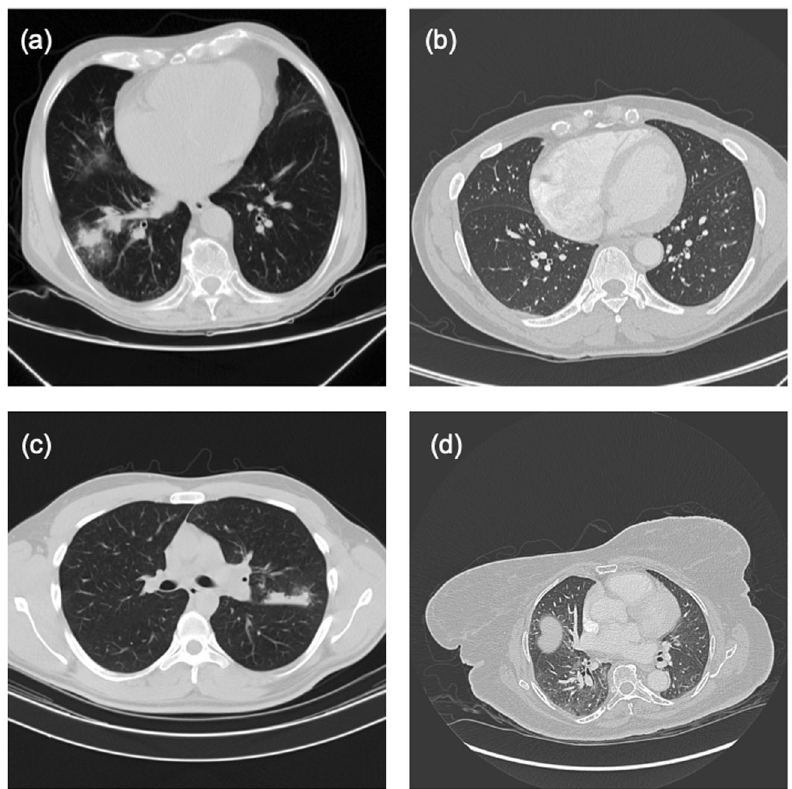
Fig. 6 Representative examples of CT images used to test the performance of CovidCTNet versus radiologists. a A CT image of CAP. This image is misidenti fi ed as Covid-19 or control by two out of four radiologists and correctly diagnosed by CovidCTNet. b A CT image of control, that was misdiagnosed by three out of four radiologists as Covid-19 or CAP and correctly diagnosed by CovidCTNet as control. c A sample of Covid-19 that was detected as Control by CovidCTNet and as Control or CAP by three out of the entire panel of radiologists (four members). d Image of control that was misdiagnosed by the CovidCTNet as CAP and by two radiologists as Covid-19 or control. Note that, in this fi gure one single slide of the entire scan is shown as a representative of all CT images of a patient.